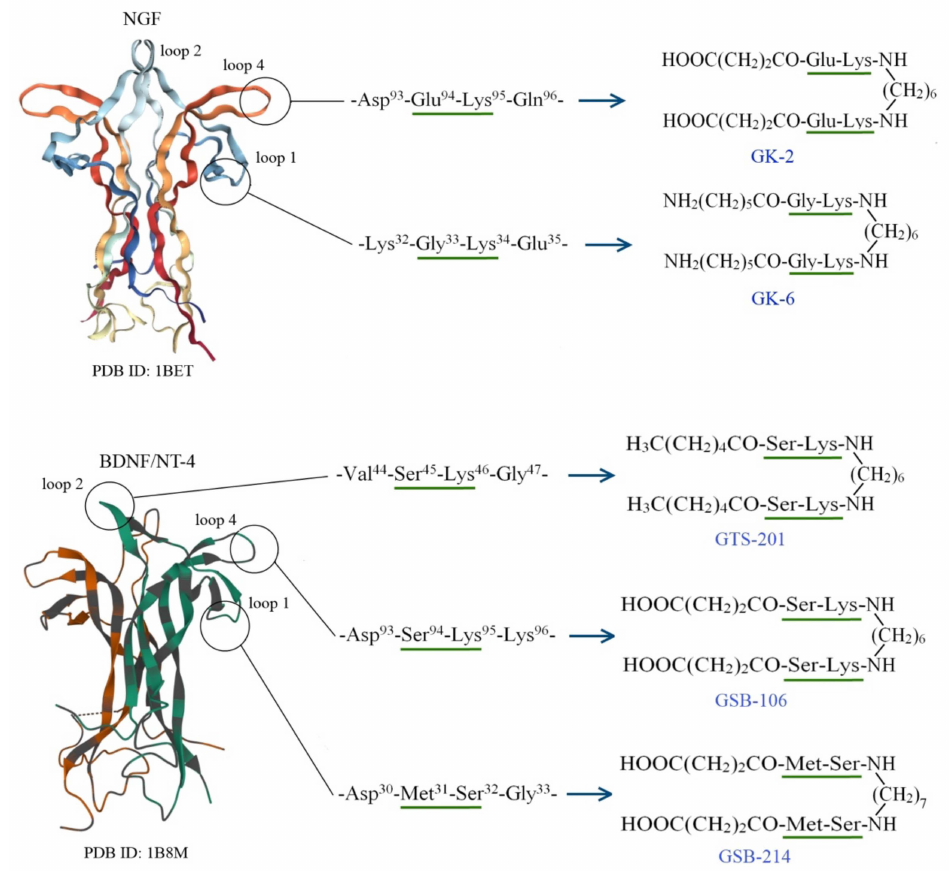
Figure 1. Design and modeling of the brain-derived neurotrophic factor (BDNF) and nerve growth factor (NGF) dipeptide mimetics.